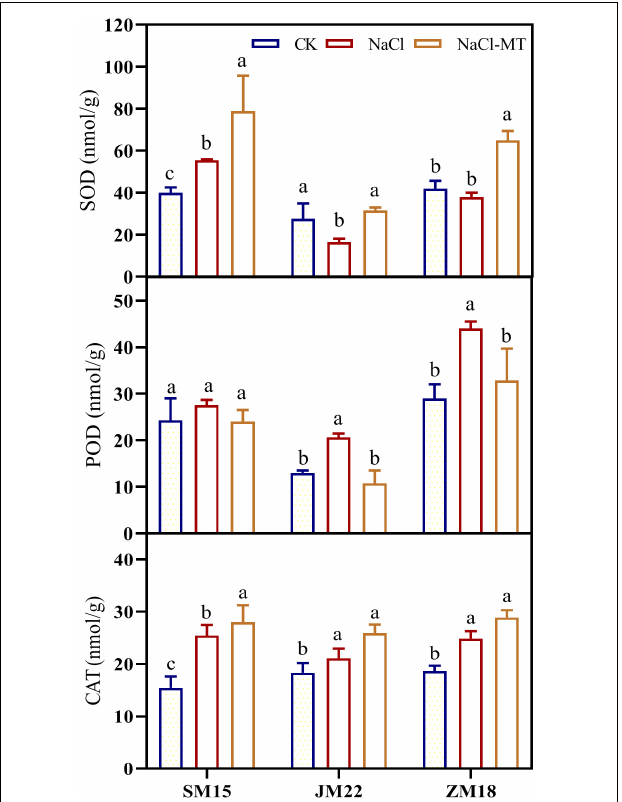
FIGURE 3 | Effects of MT on superoxide dismutase (SOD), peroxidase (POD), and catalase (CAT) under salt stress. For each trait, bars with the same letter are not significantly different according to Duncan’s test at a p < 0.05